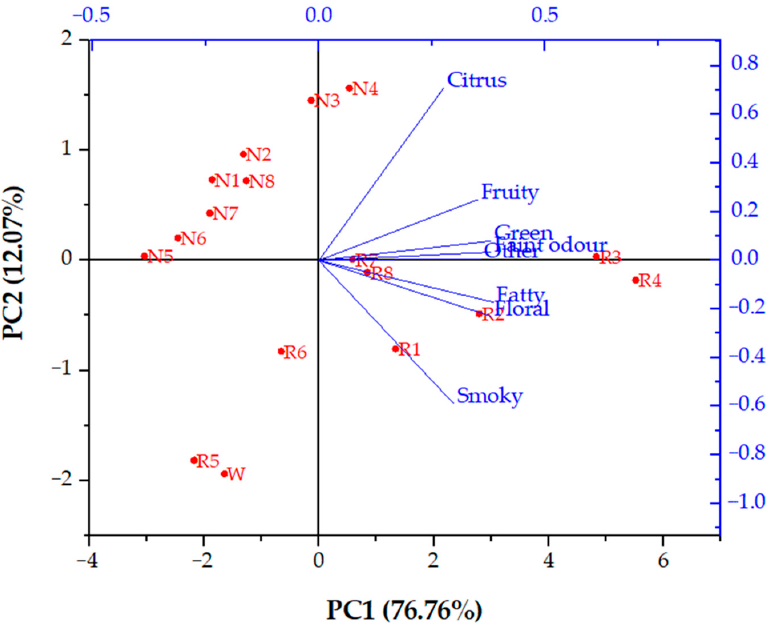
Figure 3. Principal component analysis (PCA) biplot of aroma profiles of initial wine (W) and retentates obtained by reverse osmosis (R) and nanofiltration (N). Abbreviations: 1–2.5 MPa with cooling; 2–3.5 MPa with cooling; 3–4.5 MPa with cooling; 4–5.5 MPa with cooling; 5–2.5 MPa without cooling; 6–3.5 MPa without cooling; 7–4.5 MPa without cooling; 8–5.5 MPa without cooling.